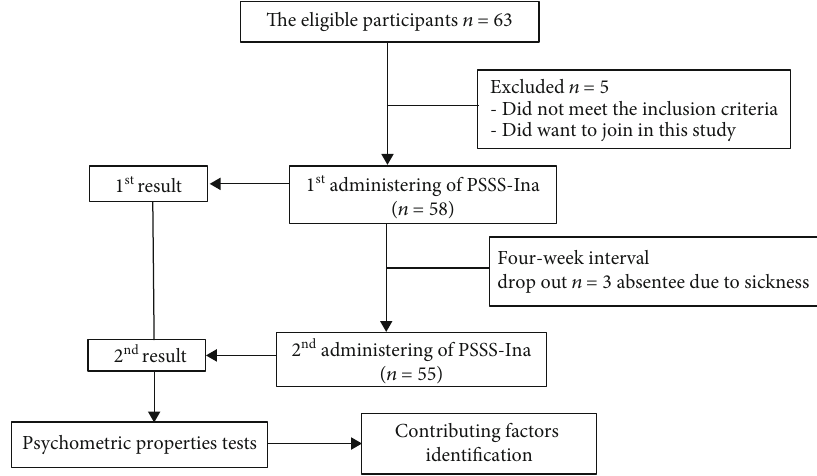
Figure 1: Flow diagram of the